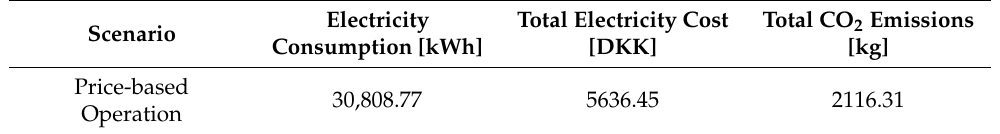
Table 10. Price-based optimization